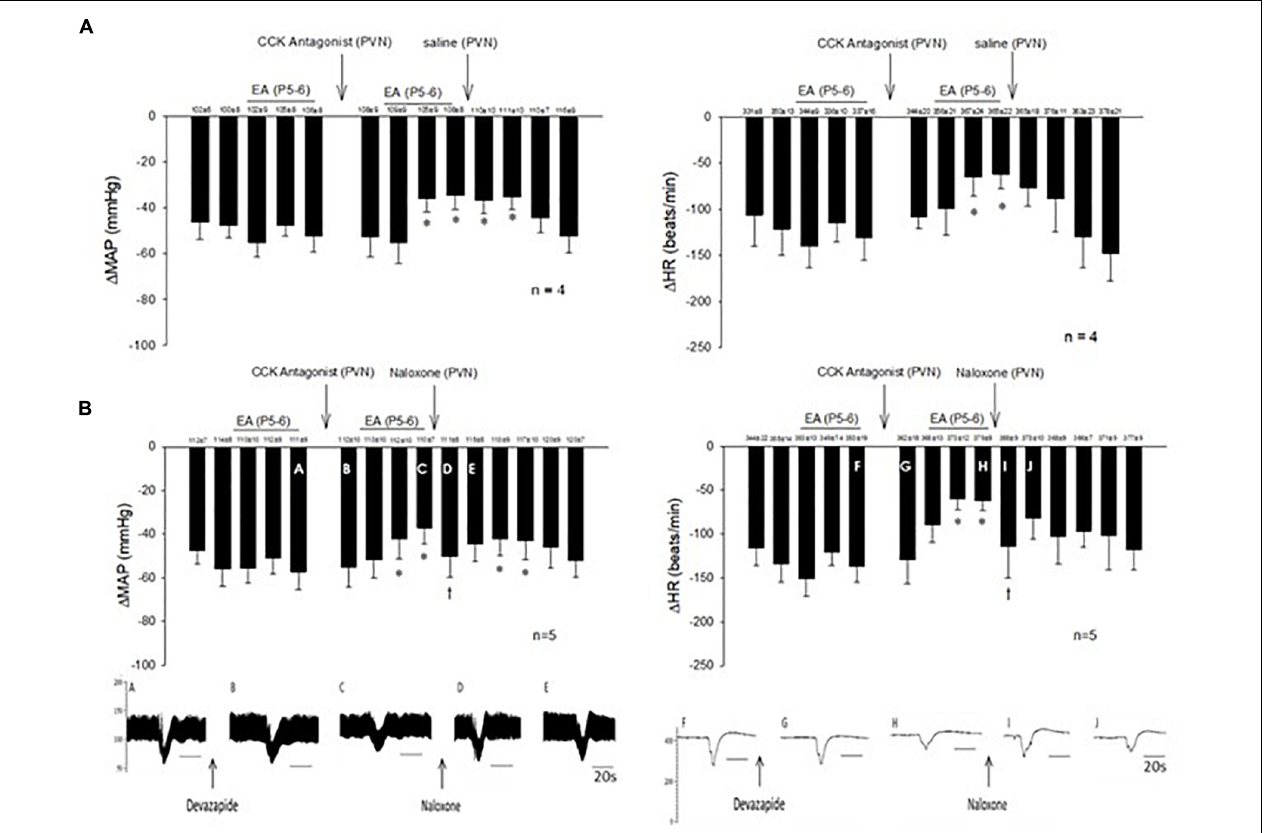
FIGURE 5 | Non-responders to EA on the Bezold-Jarisch responses were converted into responders following blockade of the CCK 1 receptor in the PVN. Unlike the responders, EA inhibition of the depressor and bradycardia was not observed in the non-responders. However, repeat EA reduced the depressor and bradycardia after microinjection of devazepide (the CCK antagonist) into the PVN in the non-responder (A) . The effectiveness of EA, after CCK1 blockade, was reversed with naloxone (B) . An individual set of data on blood pressure (A–E) and heart rate (F–J) tracings is displayed below the bar histograms. The letters above the tracings correspond with the letters shown in the bars. ∗ p < 0.05, indicates significant reduction in heart rate and blood pressure during effects of EA compared with PBG responses before EA. † p < 0.05, indicates significant reversal of EA effect following naloxone compared with PBG response prior to